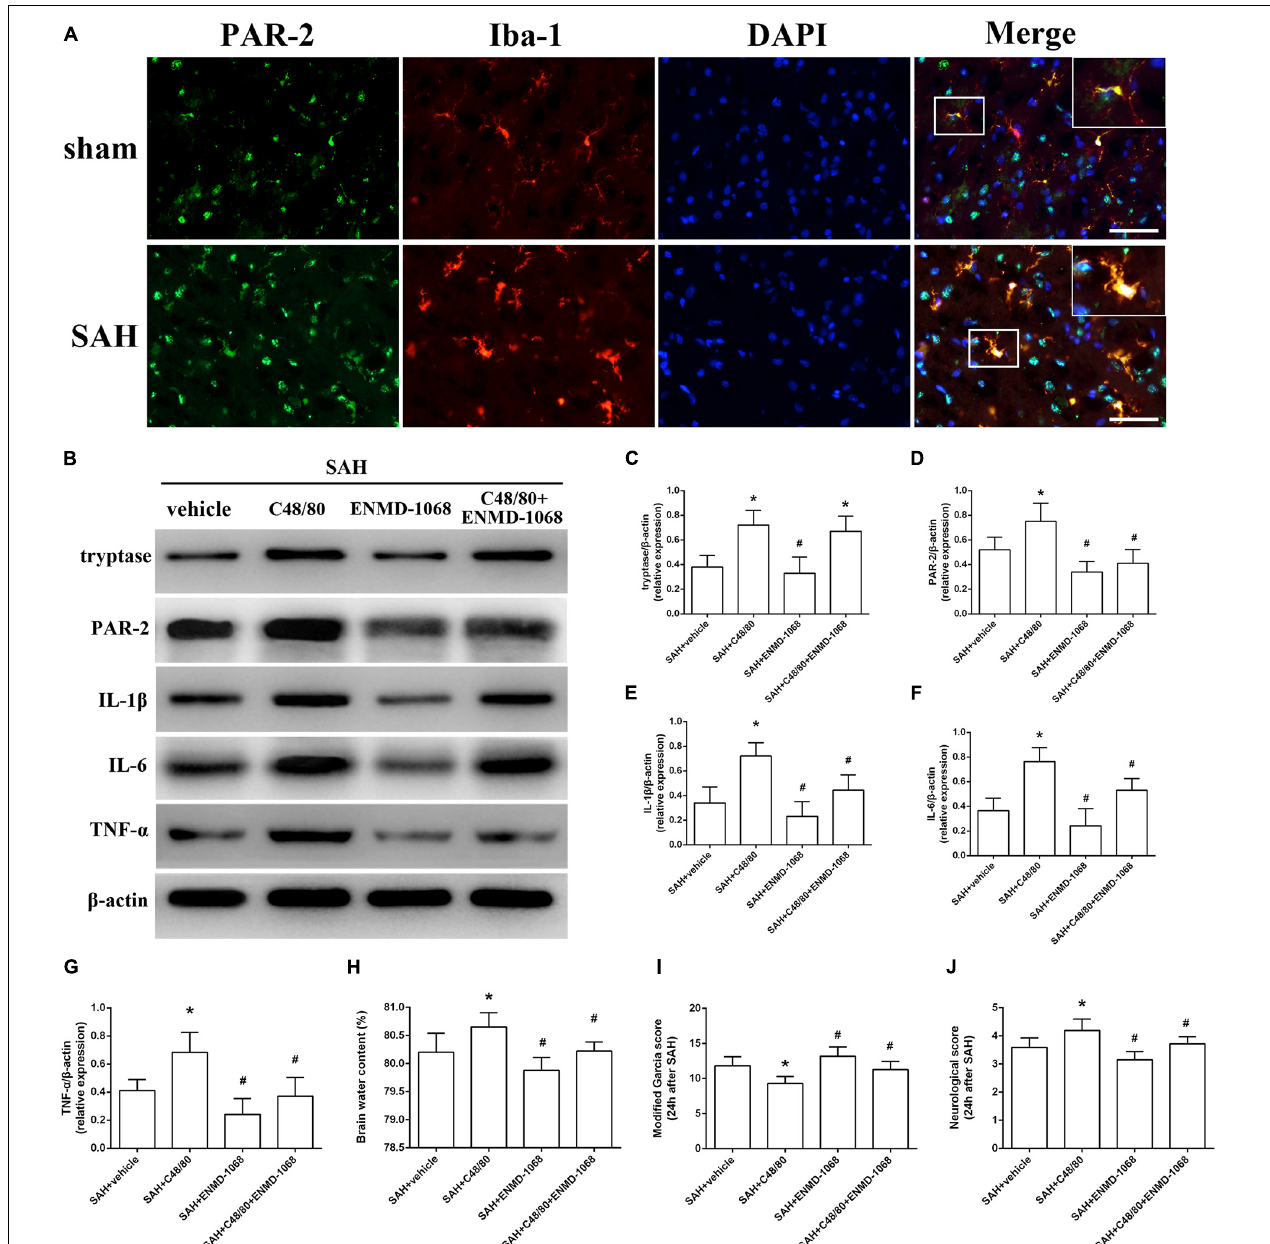
FIGURE 6 | Pharmacological inhibition of microglial PAR-2 alleviated MCs-mediated inflammatory injury at 24 h after SAH. (A) Immunofluorescence staining demonstrates the expression of PAR-2 in sham and SAH mice. n = 6. Scale bar = 50 µ m. (B–G) Representative western blotting images and quantitative analyses of tryptase, PAR-2, TNF- α , IL-1 β , and IL-6 expression in ipsilateral basal cortex after SAH. (H) The quantification of brain water content. (I,J) The quantification of neurobehavioral test. n = 6. Data are represented as mean ± SD. * P < 0.05 versus SAH + vehicle group. # P < 0.05 versus SAH + compound 48/80